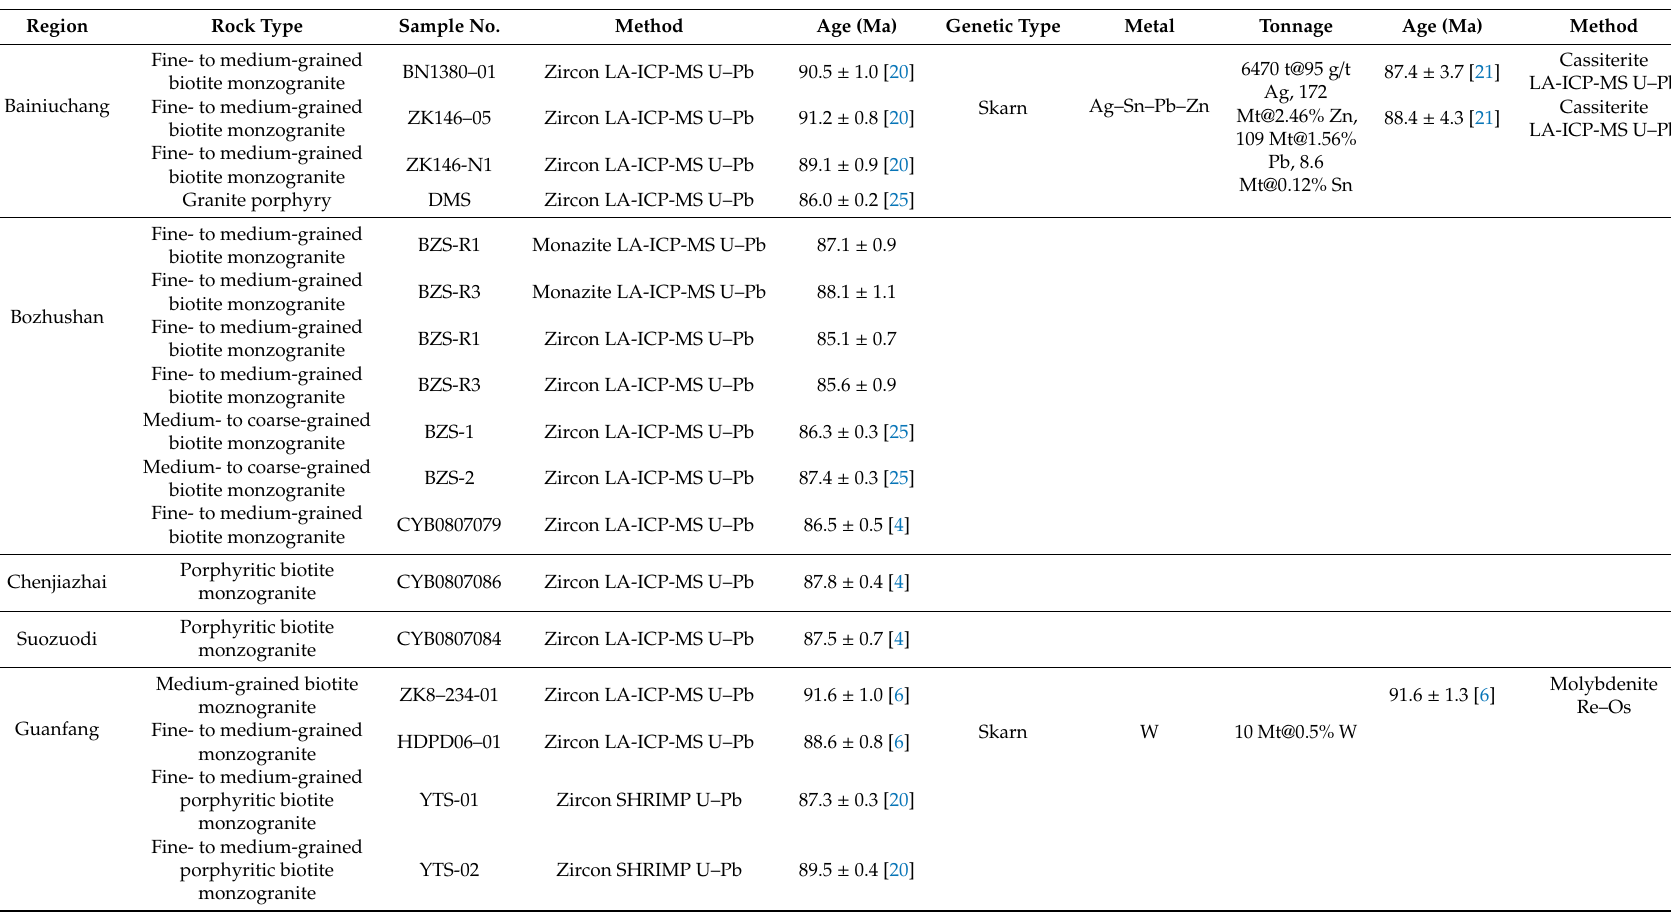
Table 3. Geochronological data for the Bozhushan batholith and representative deposits, southeastern Yunnan district.